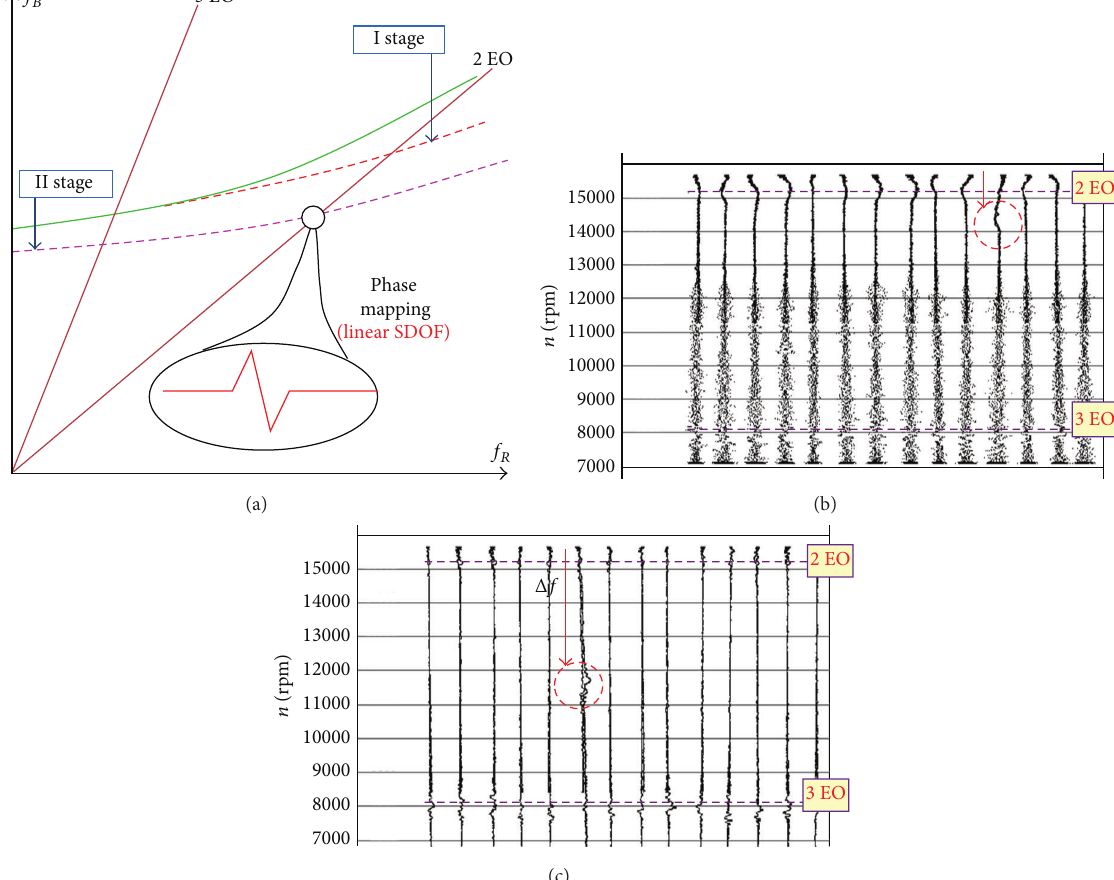
Figure 34: The effect of blade cracking [55]: (a) blade frequency plotted in the Campbell diagram; (b) the first stage of blade cracking, changes only 𝐵 ; (c) final stage of blade cracking, 5 minutes before break (signal after low-pass